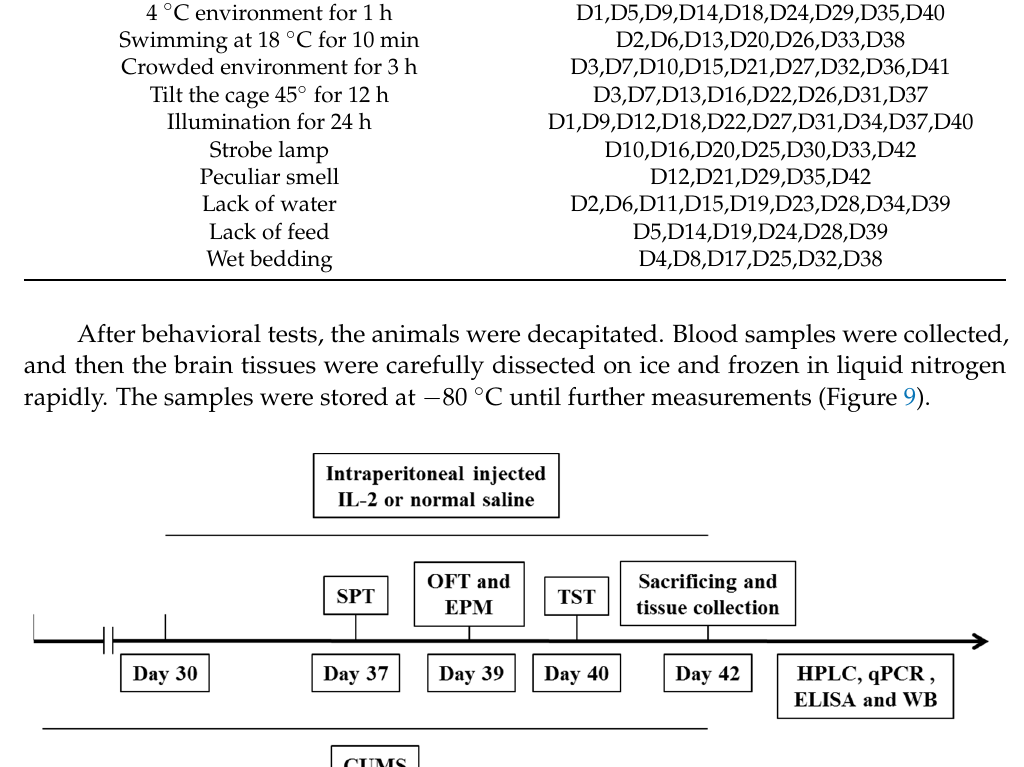
Table 1. Chronic unpredictable mild stress procedure. Dx (x = 1, 2, … 45) indicates day X.